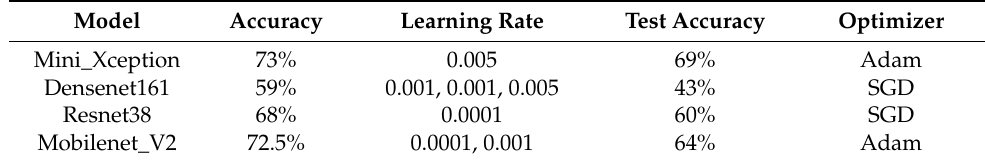
Table 2. Various Models tested on FER 2013 Database.